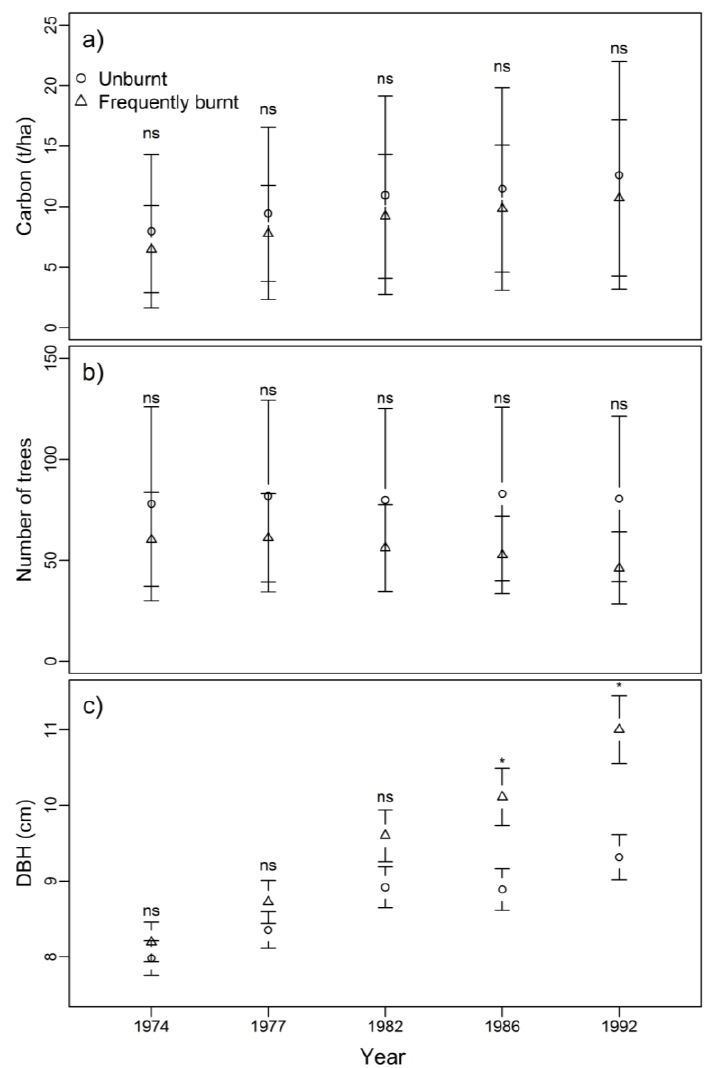
Figure 2. Mean and 95% confidence interval for ( a ) estimated carbon biomass (tha −1 ), ( b ) number of trees and ( c ) tree diameter for understorey species on frequently burnt and unburnt plots across all survey periods. Symbols above error bars show the results of one way analysis of variance ( a , b ) or linear mixed models ( c ) comparing the effects of burning within each treatment year (ns: p > 0.05; * : 0.05 > p > 0.01; ** : 0.01 > p > 0.001). Untransformed data is